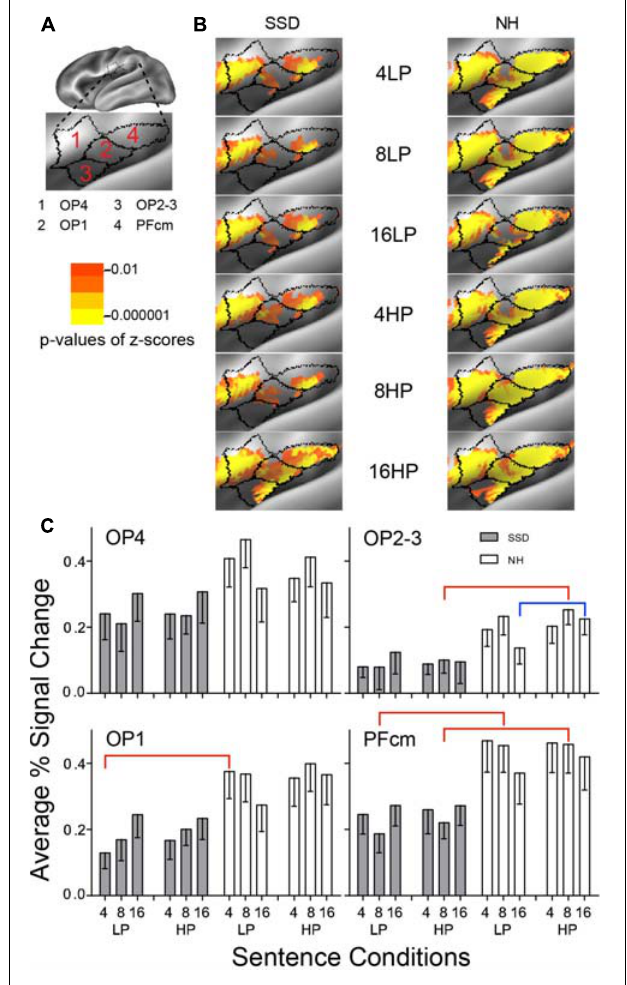
FIGURE 11 | Results from four parcels in the LH Posterior Opercular Cortex (POC) region. (A) Lateral view of a partially inflated hemisphere tilted superior 10 ◦ to expose the parietal operculum. (B) Enlarged views of parcels show clusters with significant mean z-scores of p < 0.01 for positive BOLD (colored red-orange to bright yellow). (C) OP1, OP2-3, and PFcm had significant group effects marked with red brackets. OP2-3 had a significant predictability effect marked by a blue